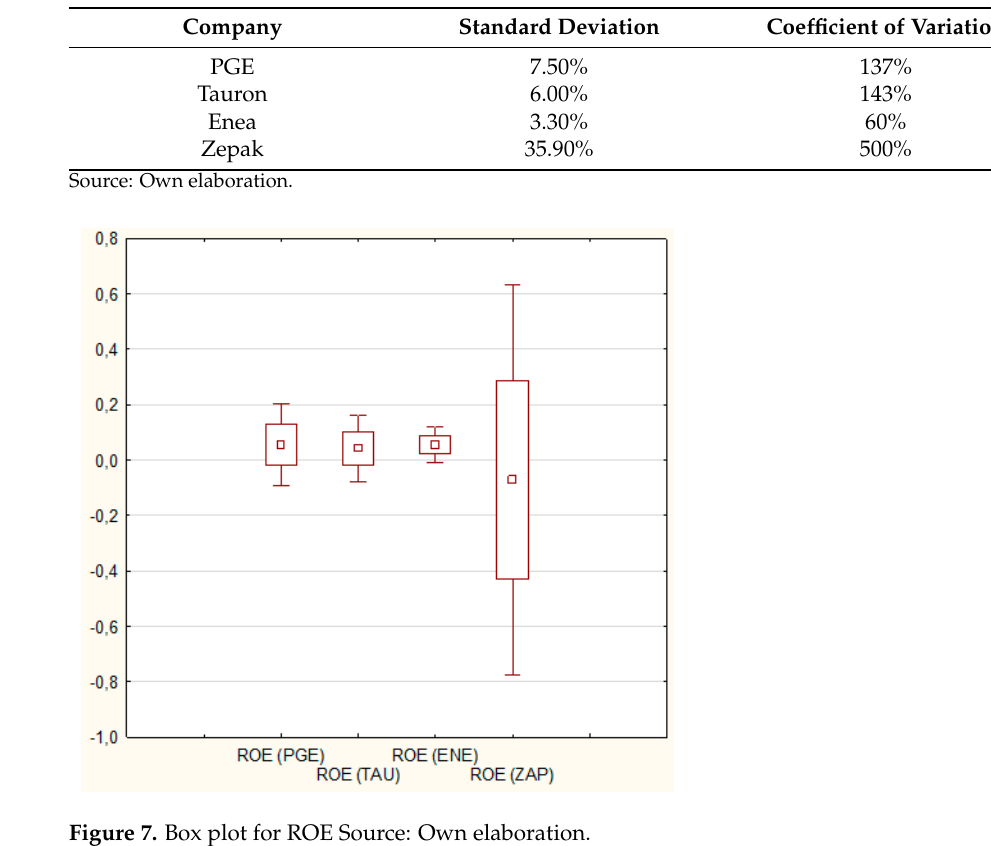
Table 3. Coefficients of variation and standard deviations for ROE of the surveyed companies.